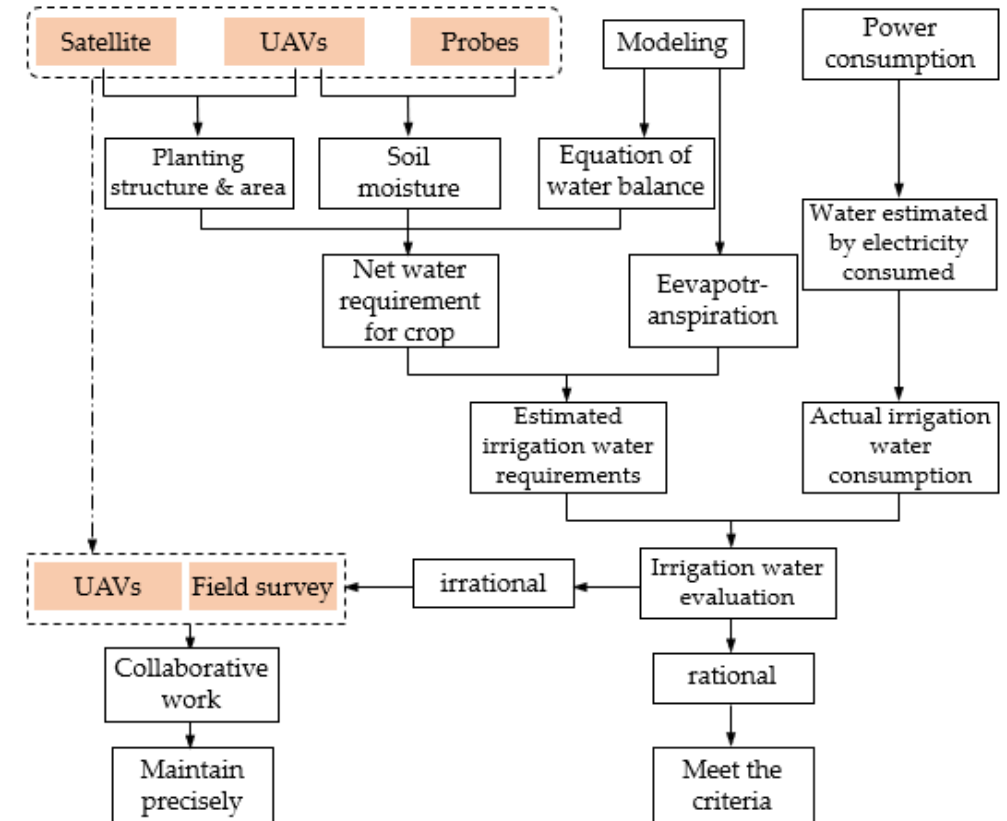
Figure 4. The flowchart of emergency maintenance of FWCP (the dotted arrow indicates that the sensing platforms in the round corner frame with a dashed line are combined with those in the dotted rectangular box to maintain precisely due to the irrational irrigation water consumption. The legend is the same as in Figure 3) .